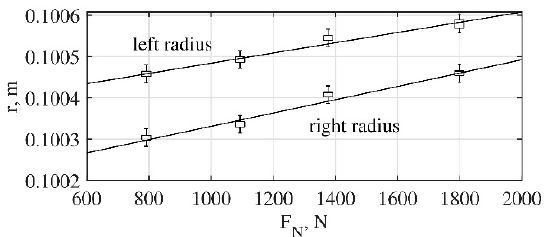
Figure 13. Comparison of the obtained rolling radius courses.